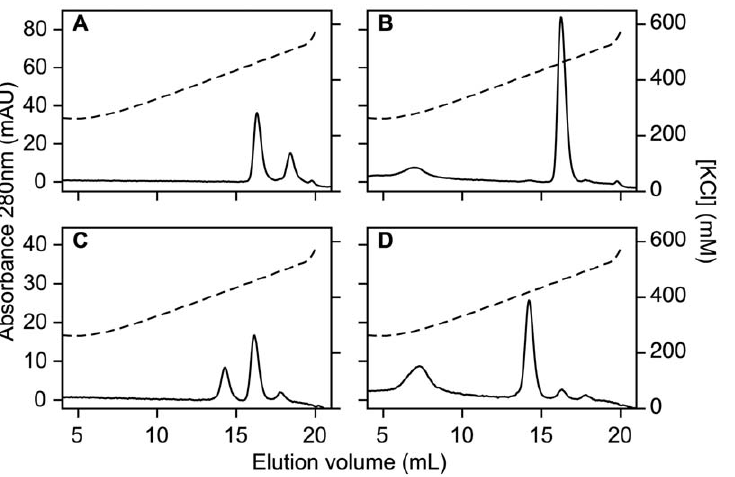
Figure 3. MonoQ anion exchange chromatography elution profiles of flavodoxin and apoflavodoxin. (A) Flavodoxin (40 m M). (B) Flavodoxin (40 m M), kept in the presence of 10 mM DTT for a period of 10 min. (C) Apoflavodoxin (50 m M). (D) Apoflavodoxin (50 m M), kept in the presence of 10 mM DTT for a period of 10 min. Gradient composition: buffer A is 25 mM Tris-HCl pH 8.0, and buffer B is 25 mM Tris-HCl pH 8.0, containing 1 M KCl. Flow rate is 1.0 mL/min. Dashed lines show conductivities of elution buffers. The molecule eluting at 7 mL is DTT. Temperature is